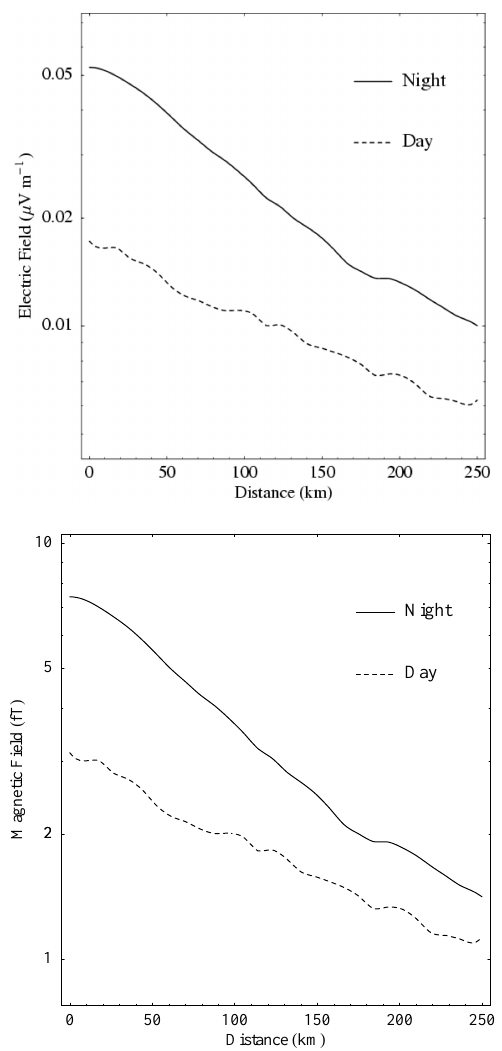
Fig. 5. The day and night electric and magnetic fields estimated due to radiation from Dunedin’s ripple control signal. Calculated for an altitude of 710km against increasing horizontal distance from the city centre.